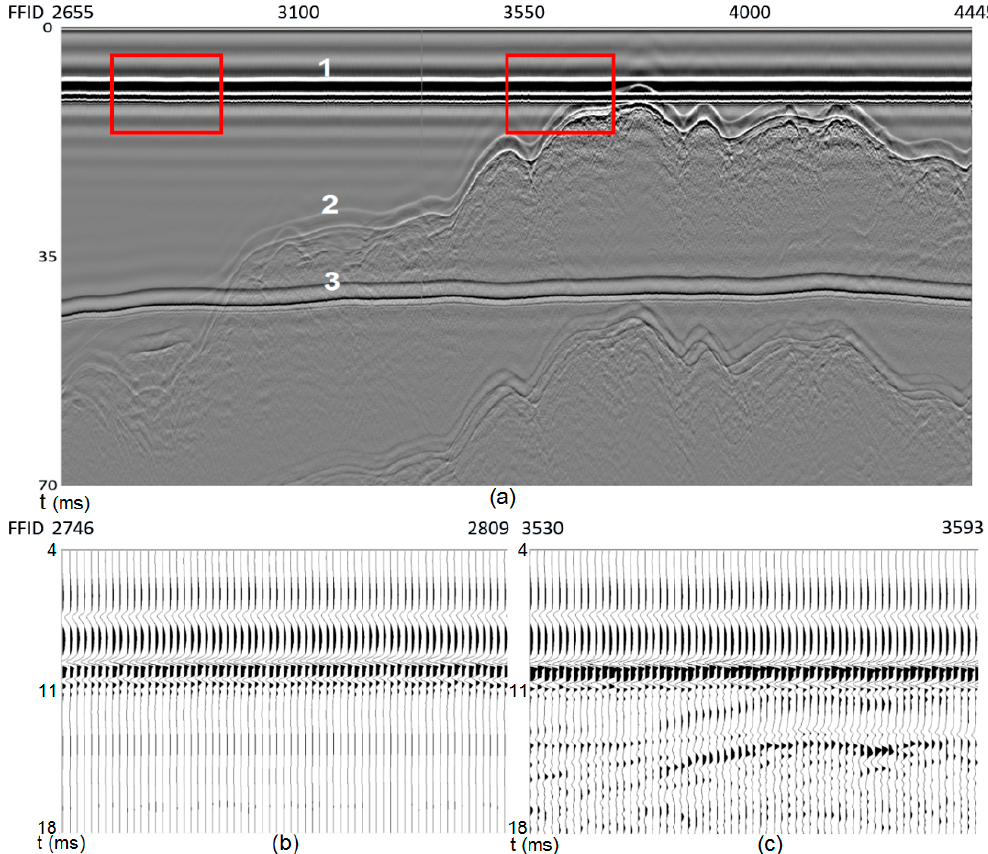
Figure 1. Examples of the wavefield registered on the investigated profile: ( a ) For an extended section of the profile and a time interval of 70 ms; ( b ) for the middle part of the profile in the direct wave region; ( c ) for the right ‐ hand part of the profile, where the interference of the direct wave with reflections from the bottom sediments is observed. The numbers in figure ( a ) indicate the types of waves: 1—direct wave, 2—reflected wave from the seabed, 3—the ghost reflection from the sea surface. The red frames in figure ( a ) denote the direct wave interval. The left frame is the signal of the direct wave without interference—figure ( b ). The right frame is a direct wave signal with interference—figure ( c ).